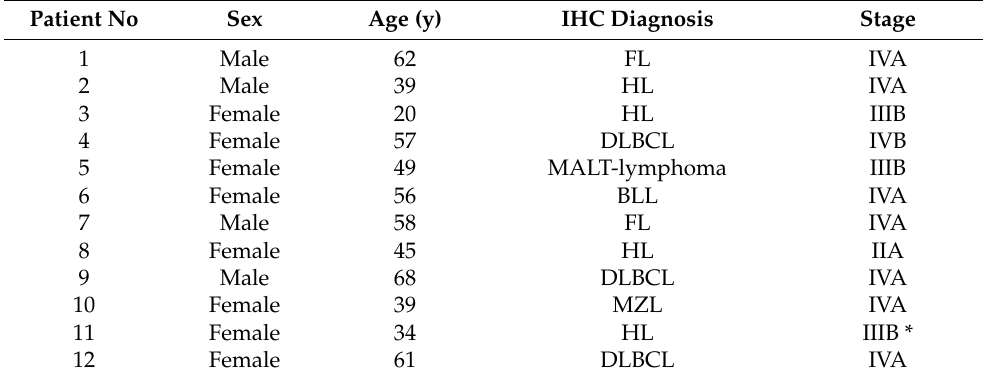
FL—Follicular lymphoma; HL—Hodgkin lymphoma; DLBCL—Diffuse large B-cell lymphoma; MALT- lymphoma—mucosa-associated lymphoid tissue lymphoma; BLL—B-lymphoblastic lymphoma; MZL—Marginal zone lymphoma. *—stage was changed to IVB based on [ 99m Tc]Tc-TG SPECT/CT and additional MRI studies performed after [ 99m Tc]Tc-TG